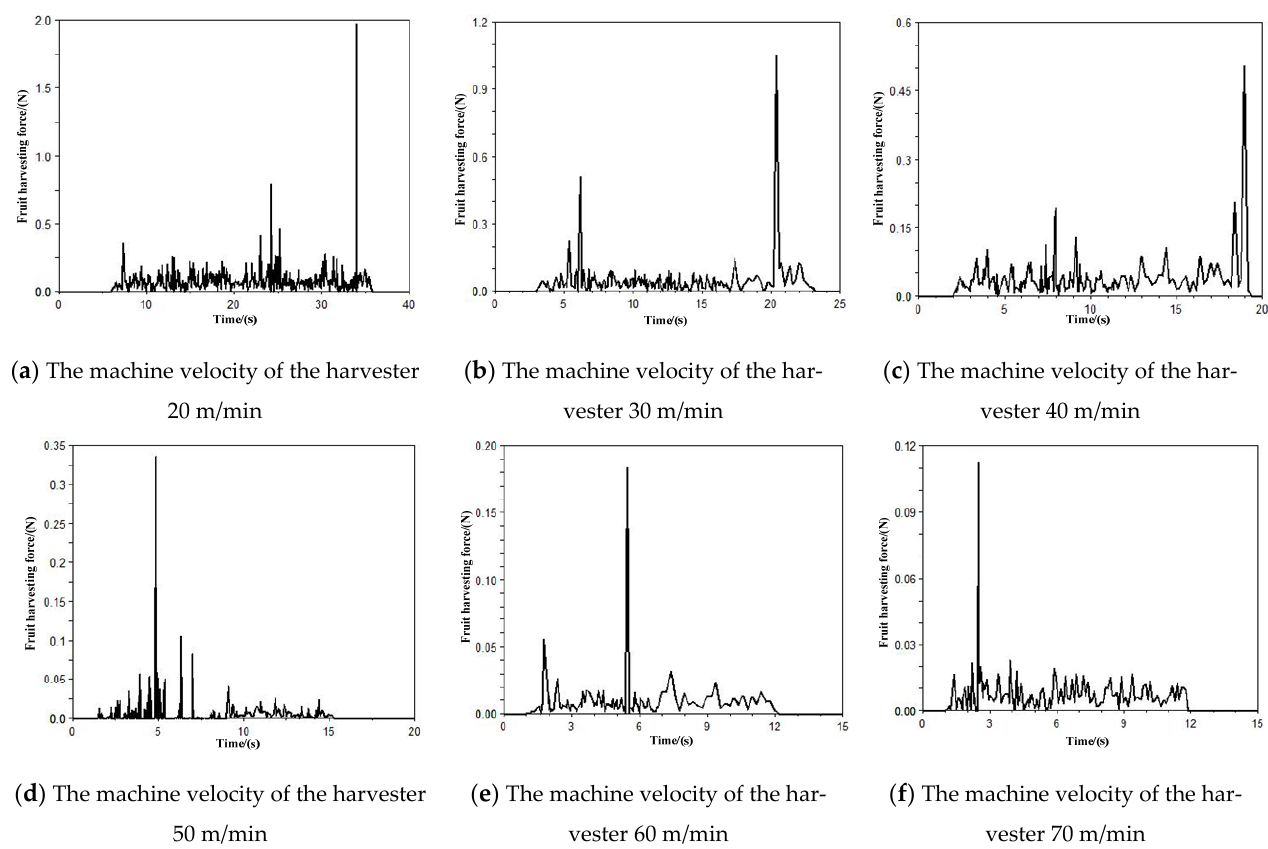
Figure 19. Analysis of the influence of the machine velocity on the blueberry fruit harvesting force. The fruit harvesting force curves under different machine velocity conditions, when the output rotational velocity of the hydraulic motor of the harvesting system was 120 r/min, are shown in Figure 19a–f. It can be seen from the figure that as the machine velocity of the harvester increased, the fruit harvesting force gradually decreased. This is due to the fact that as the machine velocity of the harvester increased, the interaction time between the finger rows of the harvester and the blueberry plant gradually decreased, the number of collisions between the two interactions also gradually decreased, the relative kinematic velocity of the tree branch gradually reduced, the size of the collision force gradually decreased, and the resulting fruit harvesting force gradually decreased. When the machine velocities of the harvester were 20 m/min and 30 m/min, the fruit harvesting forces were about 2.0 N and 1.1 N (the specific values corresponding to the maximum peak in the fruit harvesting force curves are shown in Figure 19a,b), i.e., between the bonding force between the raw fruit and the branch F 1 = 1.0 − 3.6 N , and the value of which was larger. When the machine velocities of the harvester were 40 r/min and 50 r/min, respectively, the fruit harvesting forces were about 0.51 N and 0.34 N (the specific values corresponding to the maximum peak in the fruit harvesting force curves are shown in Figure 19c,d), i.e., greater than the bonding force between the ripe fruit and the branch but smaller than the bonding force between the raw fruit and the branch, meeting the harvesting conditions. When the machine velocities of the harvester were 60 r/min and 90 r/min, respectively, the fruit harvesting forces were about 0.18 N and 0.12 N (the specific values corresponding to the maximum peak in the fruit harvesting force curves are shown in Figure 19e,f), i.e., both smaller than the bonding force between the ripe fruit and the branch F 2 = 0.26 − 0.3 N , and the value of which was small. In other words, when the machine velocity of the harvester ranged from 40 m/min to 50 m/min, the fruit harvesting force was greater than the bonding force between the ripe fruit and the branch but smaller than the bonding force between the raw fruit and the branch, meeting the harvesting conditions.